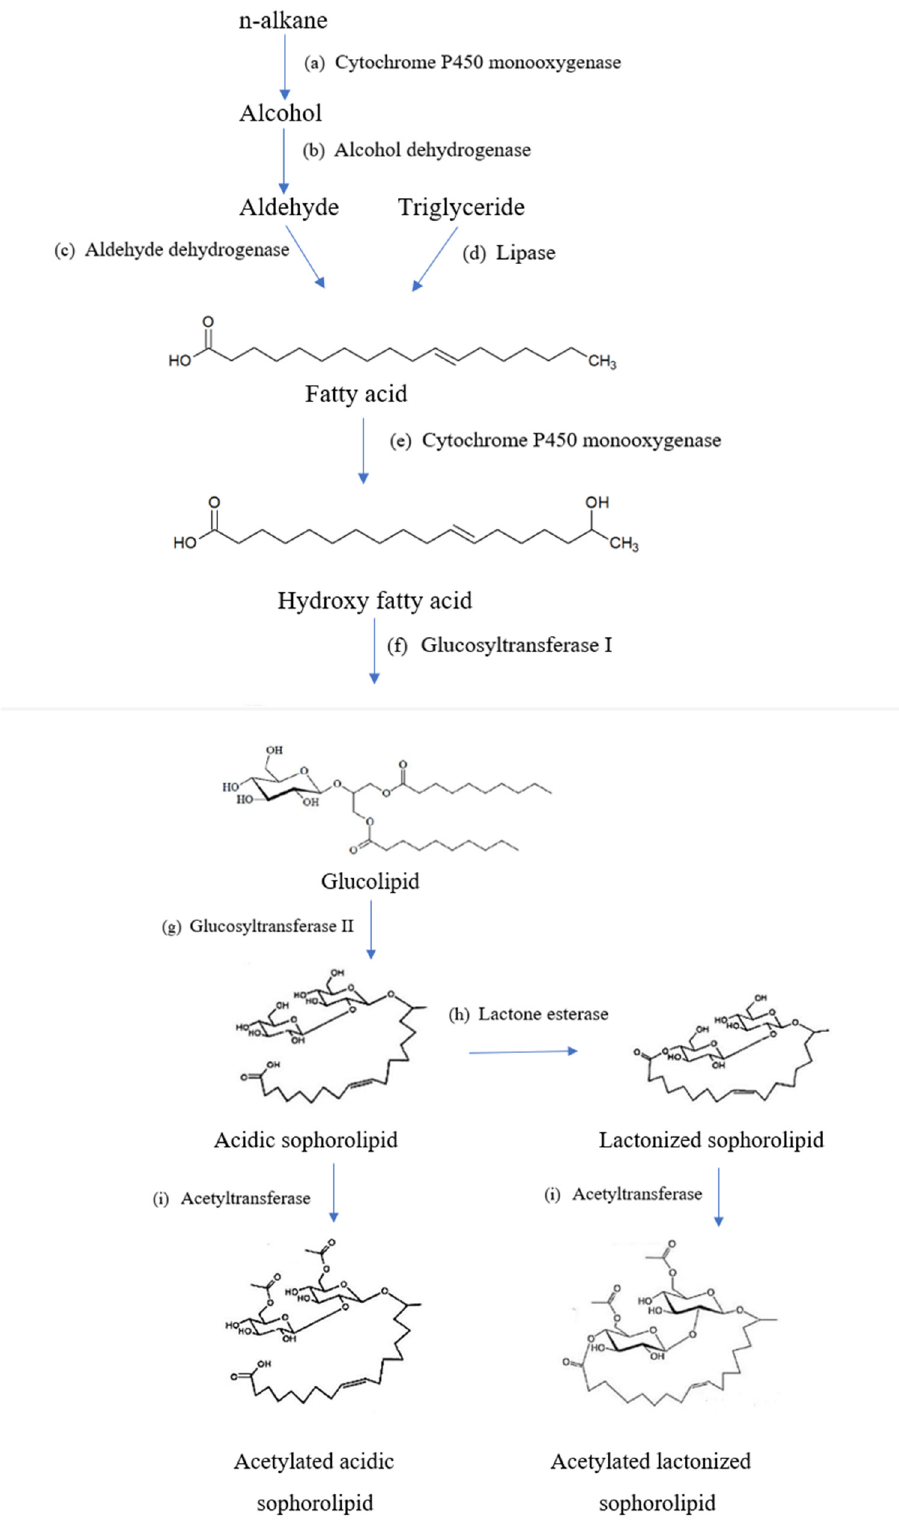
Figure 3. Overview of biochemical pathways in sophorolipid production.